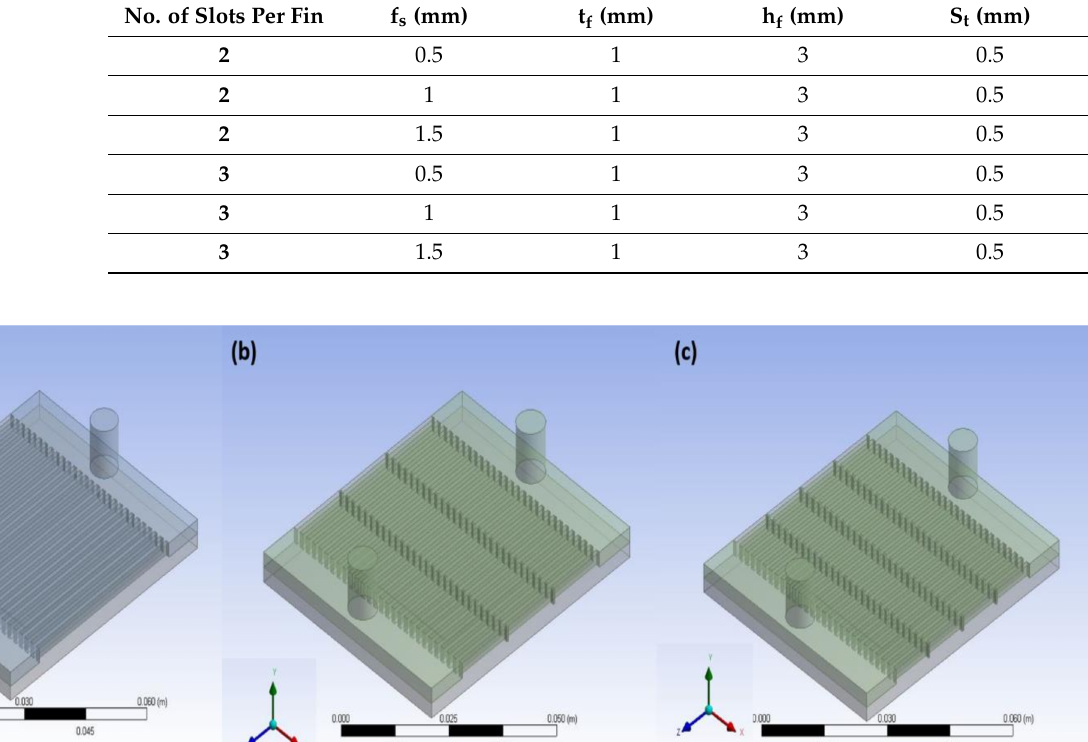
Figure 4. Isometric views for 0.5 mm fin spacing: ( a ) SIFMCHS [1], ( b ) two SPFMCHSs, and ( c ) three SPFMCHSs.